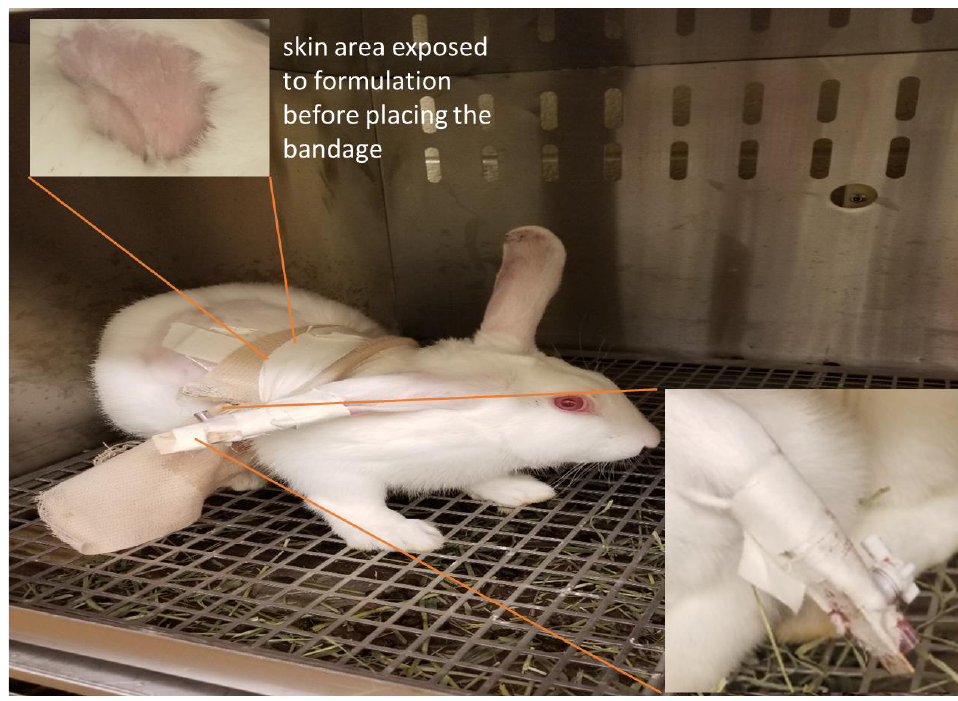
Figure 2. Image of rabbit after the catheter was fixed on the central ear artery with a three-way gate valve and further the assembly was supported by the popsicle stick and tape (in-set).